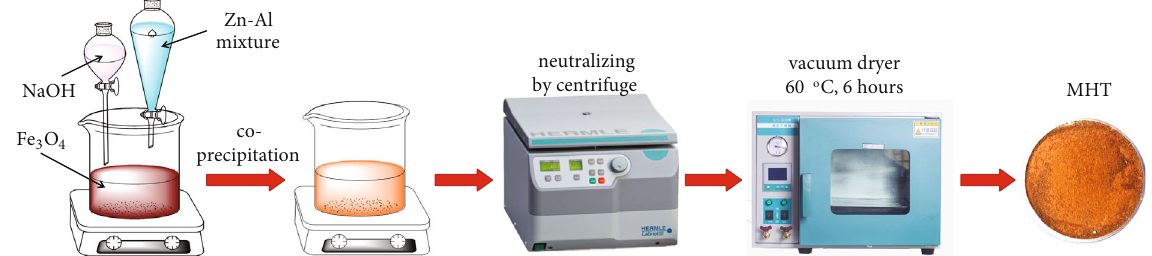
Figure 1: Schematic illustration of synthesis steps for MHT.